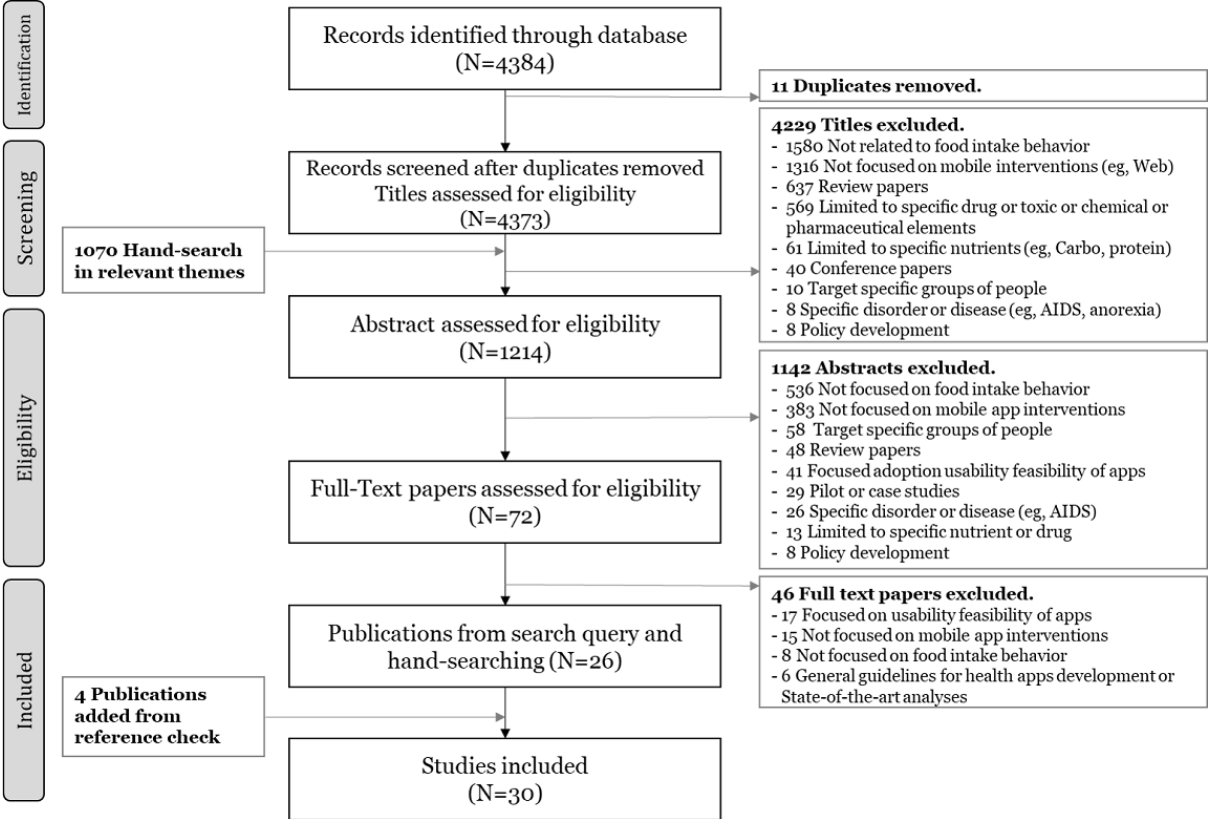
Figure 1. Flowchart of the selection process for the scoping